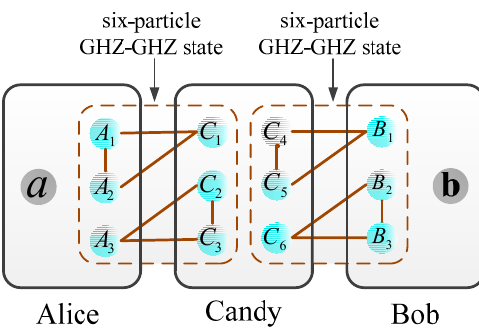
Figure 3. The composite GHZ-GHZ entanglement channel in a two-hop quantum communication case.